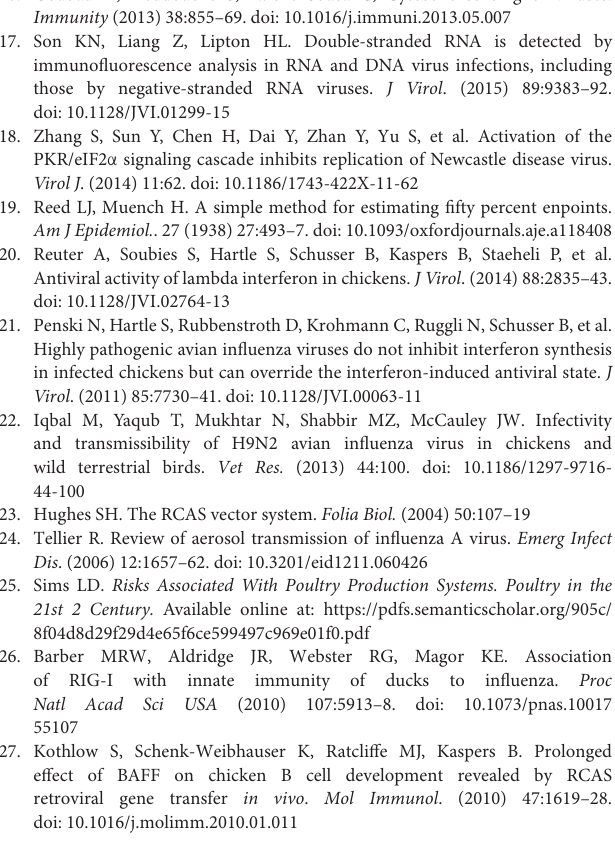
Supplementary Figure 1 | Histopathological lesions in different organs collected from transgenic or non-stransgenic chickens and challenged or not with HPAIV or vNDV. Labeling on the X-axes indicates the treatment and on the Y-axes are levels of virus challenge (clinical or lethal). Please refer to figure 7 in the main manuscript for detailed descriptions on the